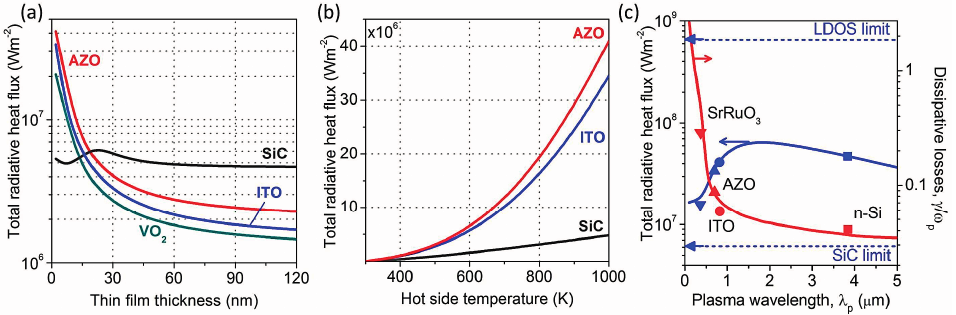
Figure 5. ( a ) The total spectrally integrated heat flux between thin films of SiC and plasmonic materials (AZO, VO 2 ) for varying thicknesses. The hot and cold side temperatures are 1000 K and 360 K, respectively. ( b ) Total integrated heat flux between 2 nm-thick plasmonic films (AZO, ITO) and 20 nm-thick SiC films as a function of the hot side temperature. The cold side temperature is 300 K. ( c ) Red line (right vertical axis): ωγ ) for a Drude metal that maximizes the optimized level of dissipative losses ( p near-field heat flux between 2 nm-thick plasmonic films as a function of the plasma = 3 ; Blue line (left vertical axis): the corresponding frequency of the metal with ε ∞ maximum total heat flux between metals with optimized dissipative losses. The dissipative loss parameters and the total heat flux between 2 nm-films of real plasmonic materials are shown as symbols (downward-pointing triangles: SrRuO 3 [42], upward-pointing triangles: AZO, circles: ITO, squares: doped Si [31–33,46,47]). The maximum possible total heat flux across the 20 nm gap (LDOS limit) and the total flux between the SiC films of optimized thickness (SiC) limit are also plotted as dotted lines for comparison. In all the panels, the emitter and absorber are separated by a 20 nm